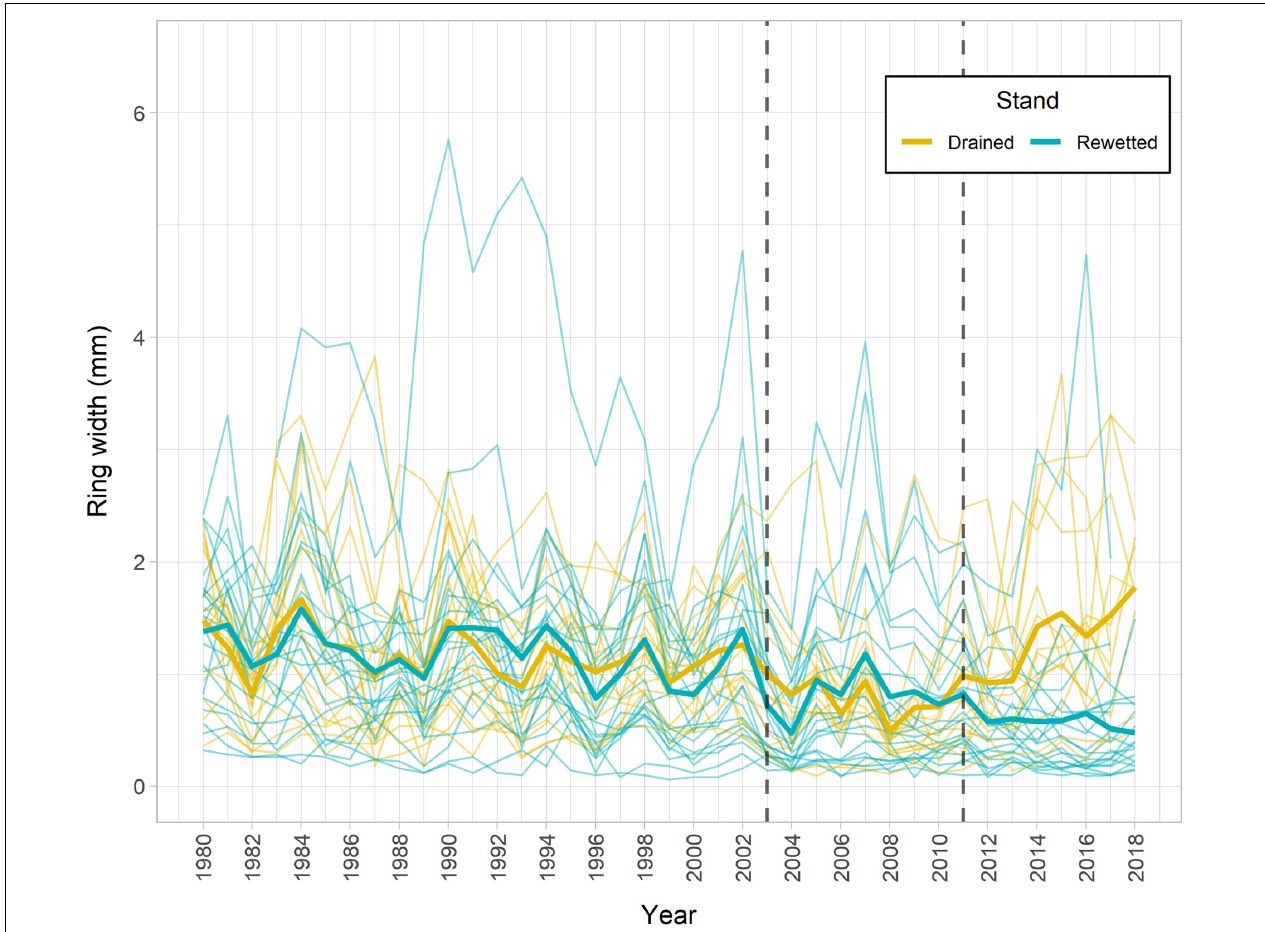
FIGURE 2 | Alder tree-ring width (TRW) chronology for the study period 1994–2018 for both stands, including some years prior to 1994. Individual tree chronologies are shown in thin lines and mean average chronologies for each stand are shown in thick lines. Vertical dotted lines indicate the year of rewetting (2003) and the year of extreme flooding (2011).